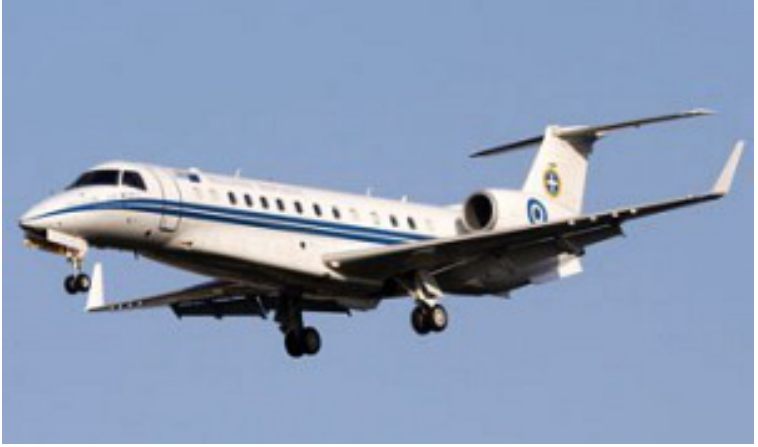
Figure 2. HAF VIP EMB-135 LR [11].